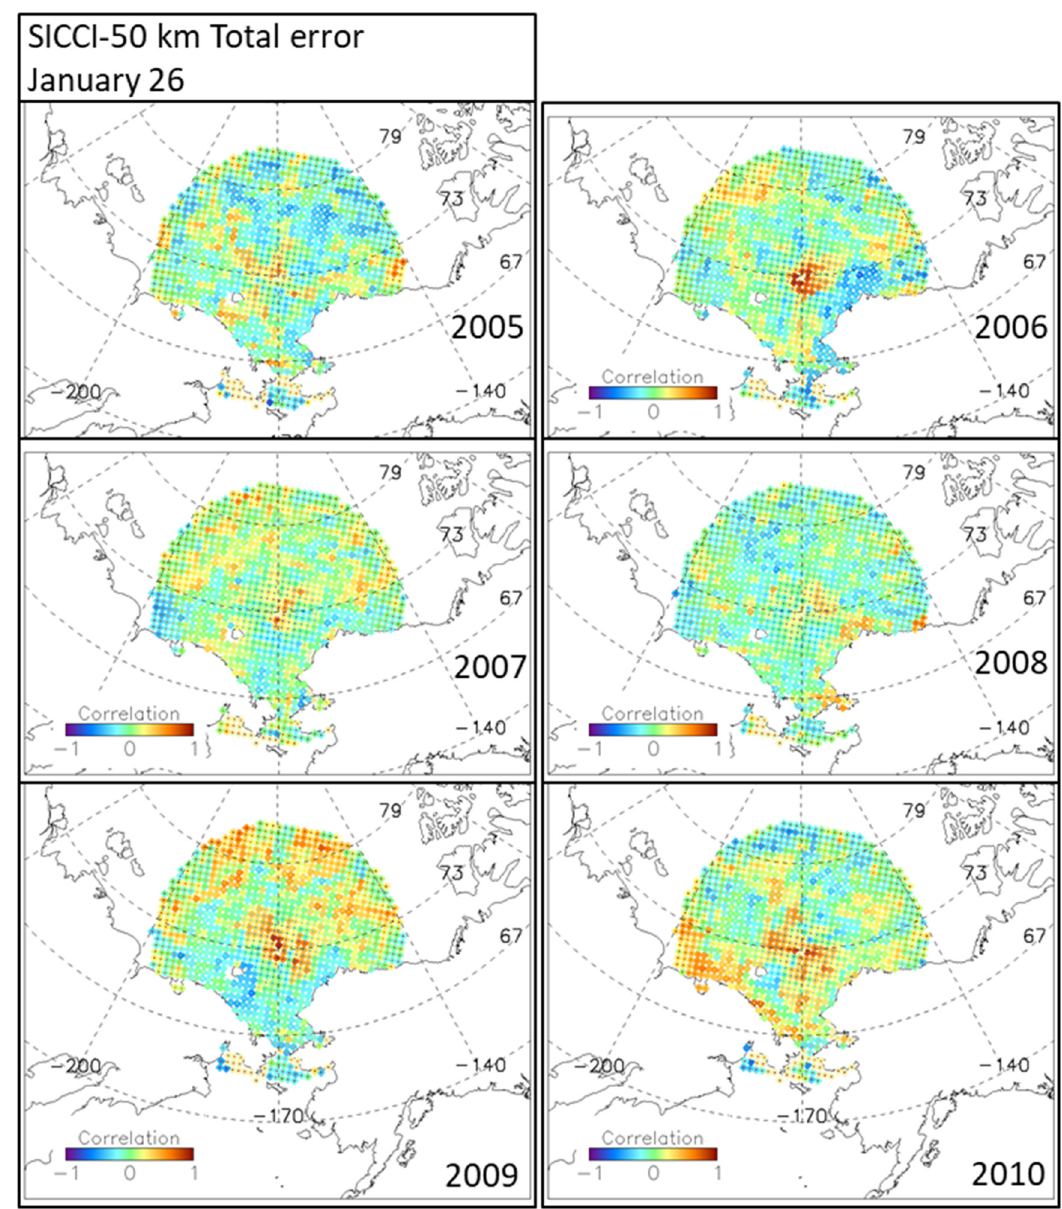
Figure 9. Correlation discs obtained for the SICCI-50km total error for 26 January of years 2005 through 2010 in the area north of the Bering Strait shown in Figure 3b. Note that the correlation in the center of the disc equals 1 and is not shown.